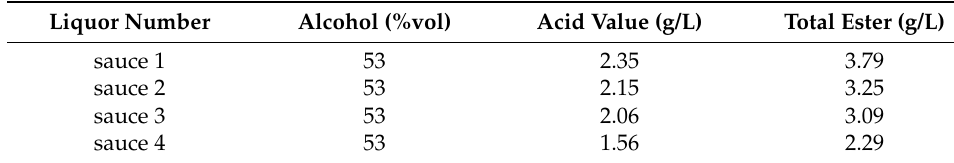
Table 2. Sample parameters of sauce-flavored